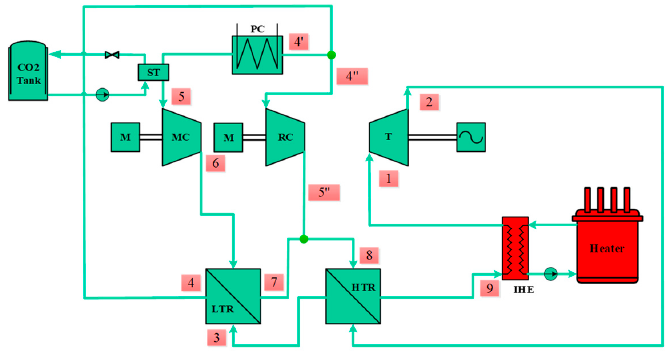
Figure 4. Supercritical carbon dioxide recompression cycle power generation system.